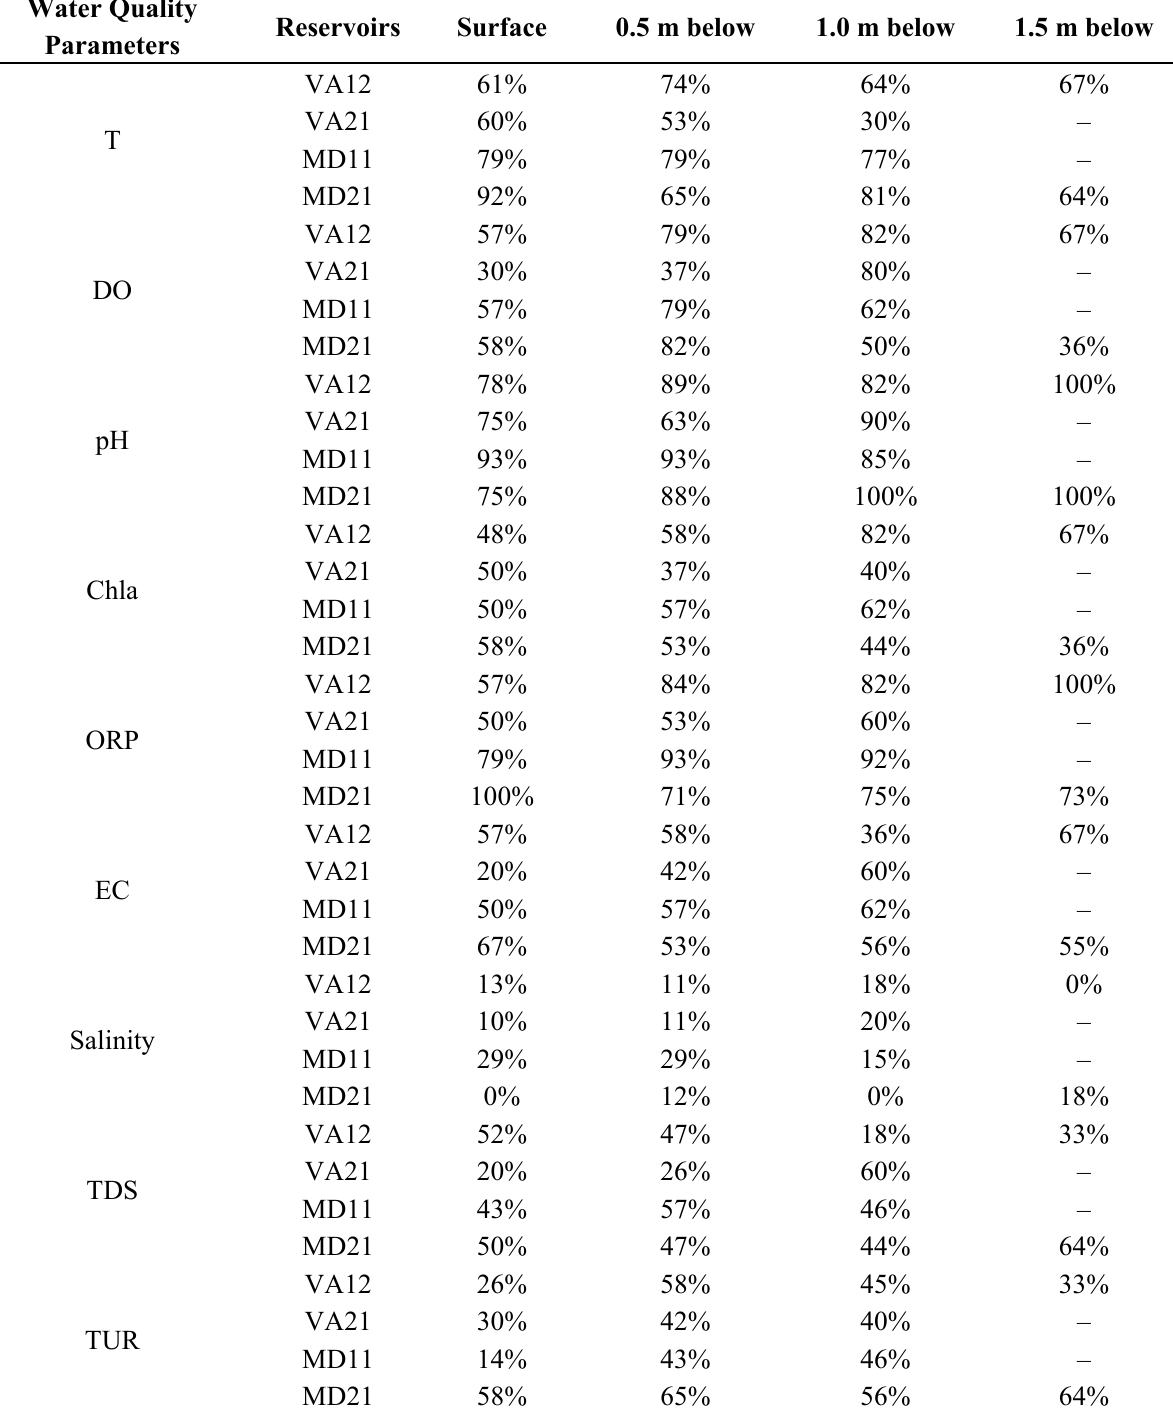
Table 3. Percentage of observations (sampling dates) with statistically significant water quality differences between the middle and entrance in each RIR studied ( p < 0.05 considered as statistically